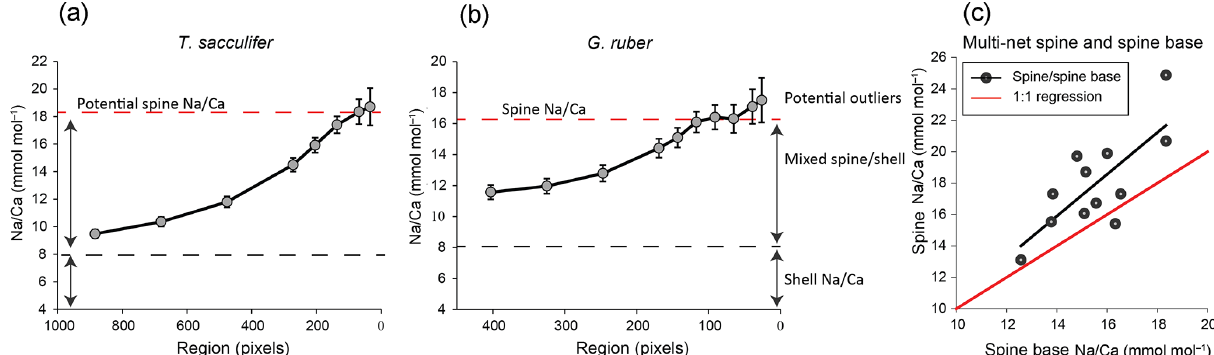
Figure 6. Examples of results of our spine-base quantification method, with (a) example of the quantification of a spine base ( T. sacculifer , 2_12_multinet, Table 3), (b) similar for G. ruber , (4_13_multinet, Table 4). The smaller/narrower the selected region, the higher the Na / Ca values, resulting from confining the analysis to the core of the spine. Due to the decreasing sampling volume, standard errors also increase. Panel (c) shows the spine Na / Ca values measured, versus the spine base Na / Ca obtained with the method described in Sect. 6, Fig. S3 and Sect. 4.2. For panel (a) the word “potential” is used, as no plateau Na / Ca value is